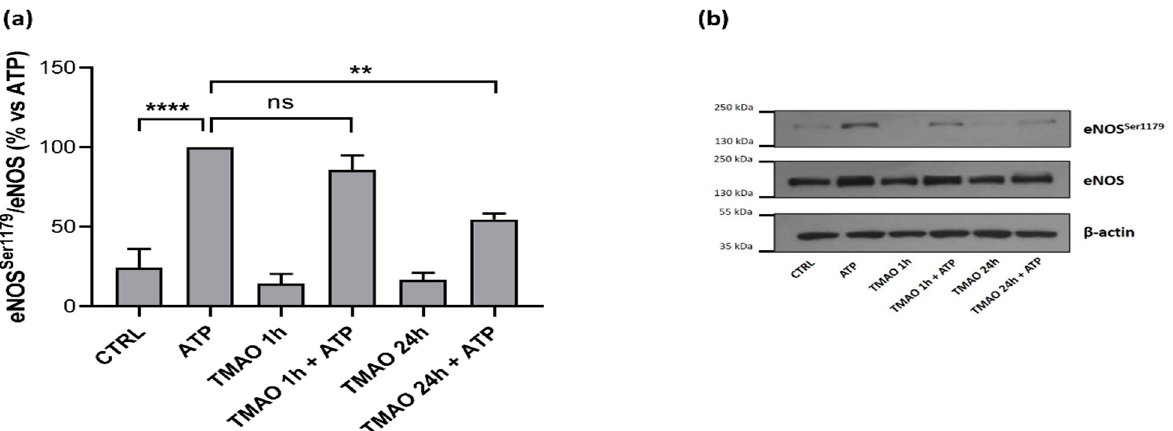
Figure 6. TMAO impacts on eNOS phosphorylation at Ser1179 in purinergic stimulation with ATP. ( a ) Basal treatment with TMAO for 1 h and 24 h did not induce any variation in eNOS phosphorylation, while treatment for 24 h induced a reduction of eNOS Ser1179 /eNOS ratio in purinergic response to ATP. (n = 4 independent experiments). **** p < 0.0001; ** p < 0.01. ( b ) Representative Western blot showing the effect of TMAO treatment for 1 h and 24 h in eNOS phosphorylation at Ser1179 after ATP stimulation.